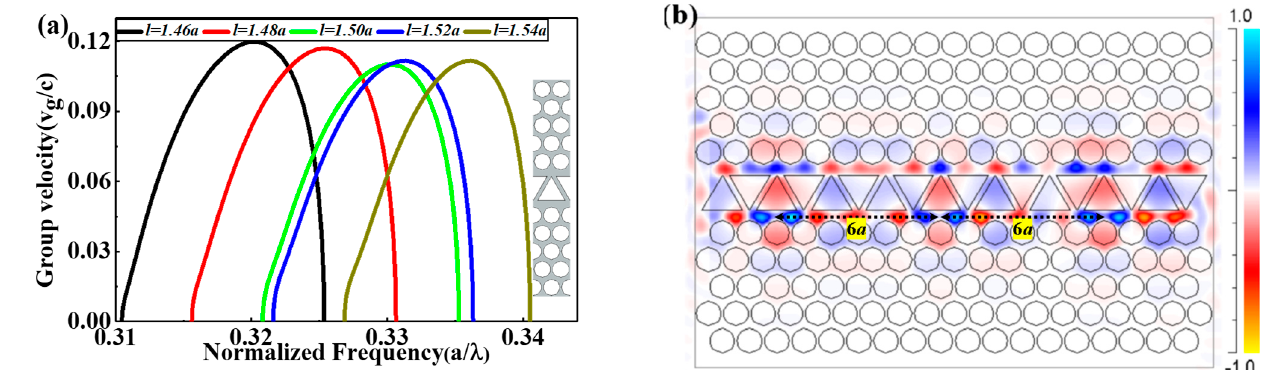
Figure 3. ( a ) Group velocity for TM guided-mode with the normalized frequency U = ω a /2 π c = a / λ at different values of l , whereas the inset figure shows the supercell model for PWE calculations; ( b ) the M-field profile of the transmission pulse at l = 1.50 a.